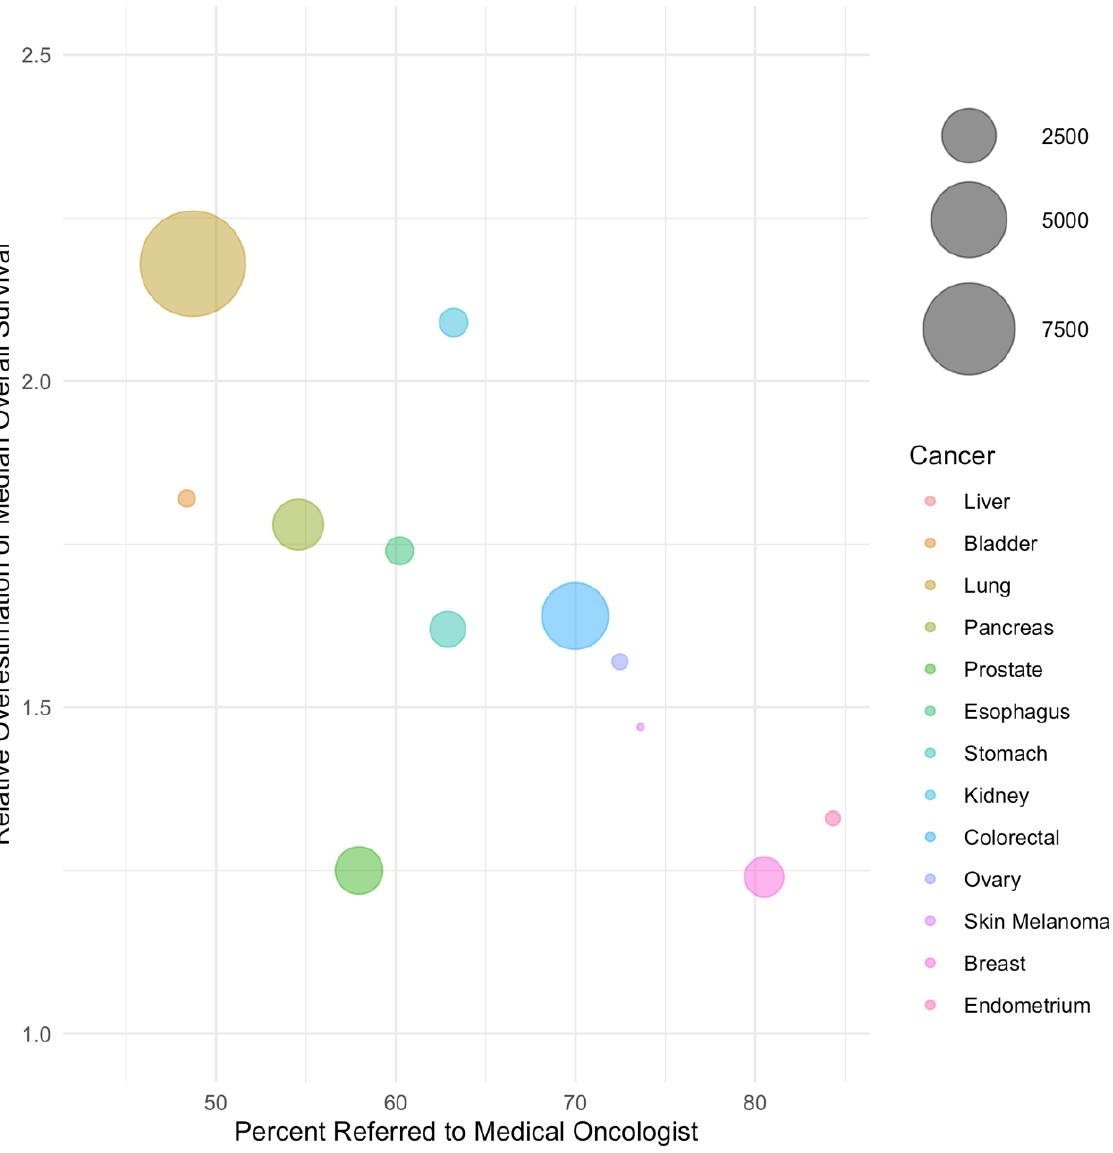
Figure 2. The relative overestimation of median overall survival in samples of referred patients compared to population-based samples by cancer site. Cancer sites are listed in order of ascending referral rate and bubble sizes are proportional to the number of patients in each cancer site. Table 3. Results from weighted regression analysis estimating the magnitude of relative bias for treatment initiation and median overall survival associated with different rates of referral to a medical oncologist in Alberta,